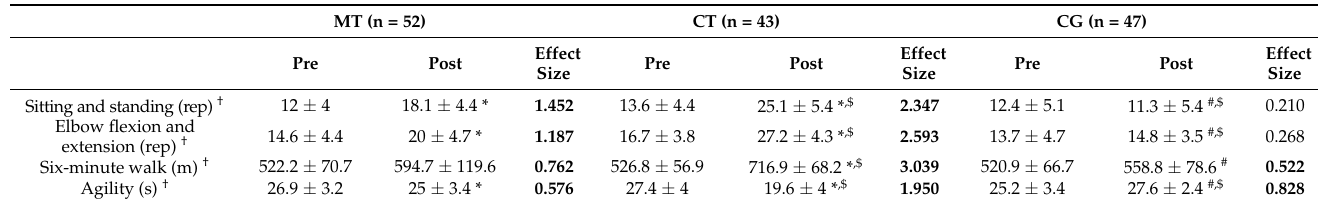
Table 2. Assessments of physical and functional capabilities through motor